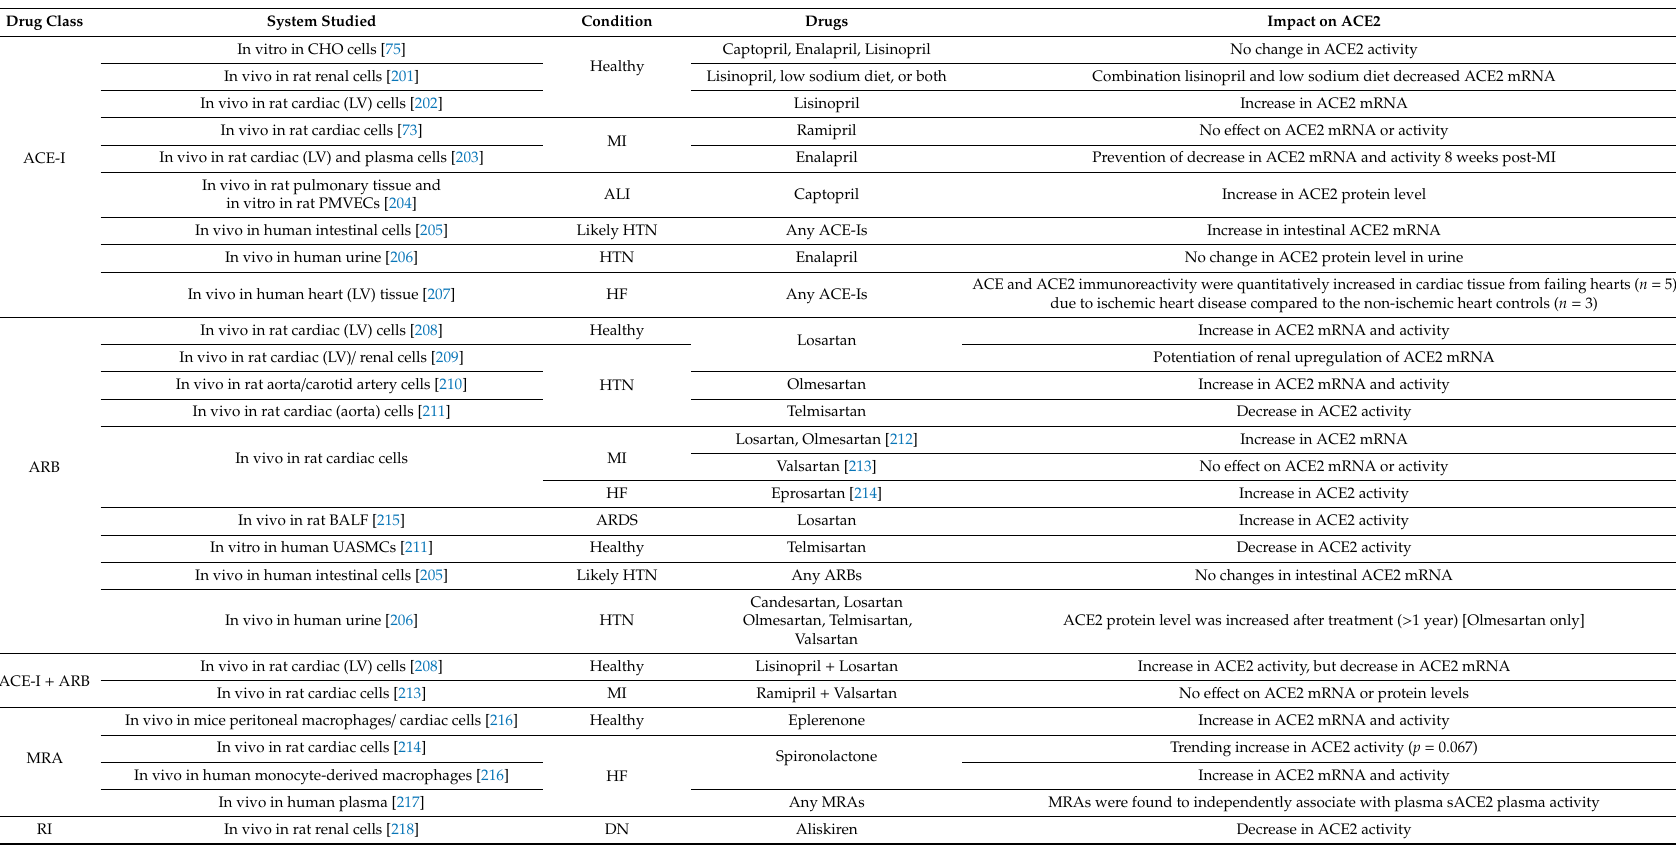
Table 1. Clinical and experimental studies investigating impacts of several cardiopulmonary diseases and RAAS modulators on ACE2 expression and activity. Drug